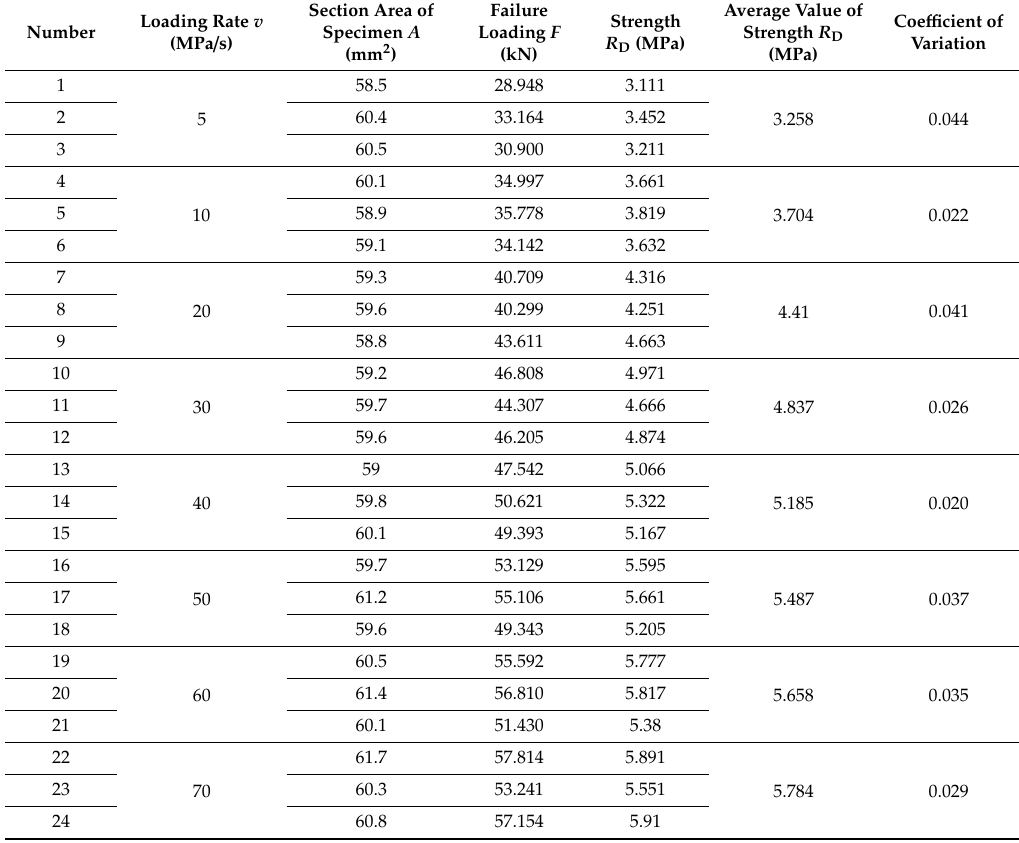
Table 6. Indirect tensile strength test of asphalt